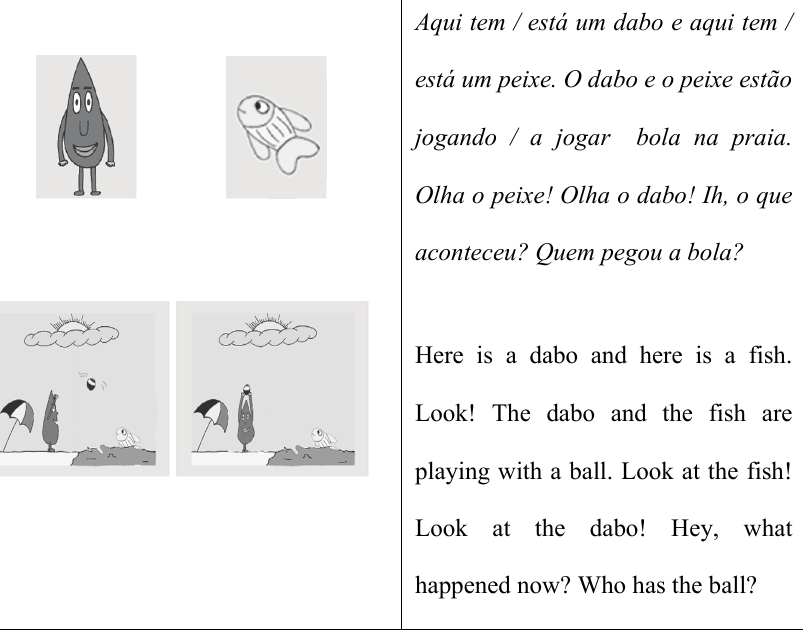
Figure 2: An example of a test story (characters and story pictures, and a description of what was told to the